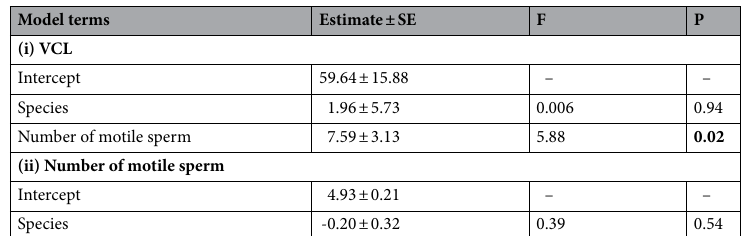
Table 2. Linear mixed models testing for the effect of (i) species identity and total number of motile sperm on sperm velocity in the cell culture medium (DMEM), and (ii) species identity on the number of motile sperm. In both models, the common nightingale was set as the reference species. The estimates, standard errors (± SE), F-stats and P-values are shown, with significant P-values in bold.